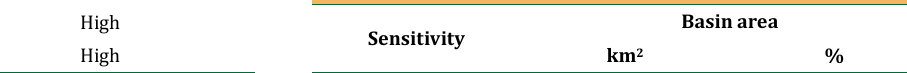
Slope sensitivity map to erosion of Mellegue catchment The zones with medium sensitivity to water erosion occupy 43% of the basin area and are mainly located at glacis surfaces of both Meskiana and Chabro wadis. On the other hand, areas with steep slopes (> 10%) are less dominant and occupy mainly the hillslopes of the Meskiana and Chabro sub-basins (Table 3). Table